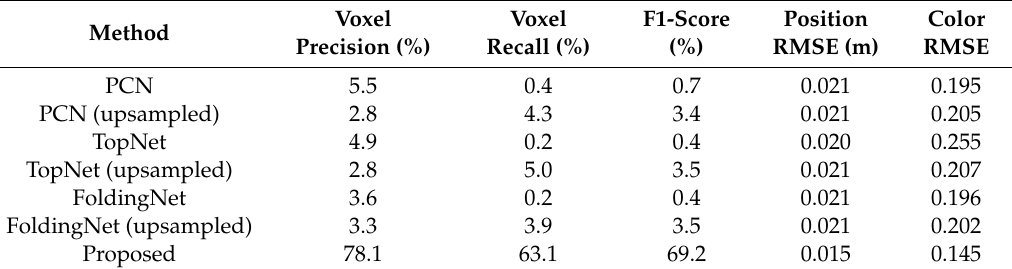
Table 8. Comparison of performance metrics with point-based neural networks.